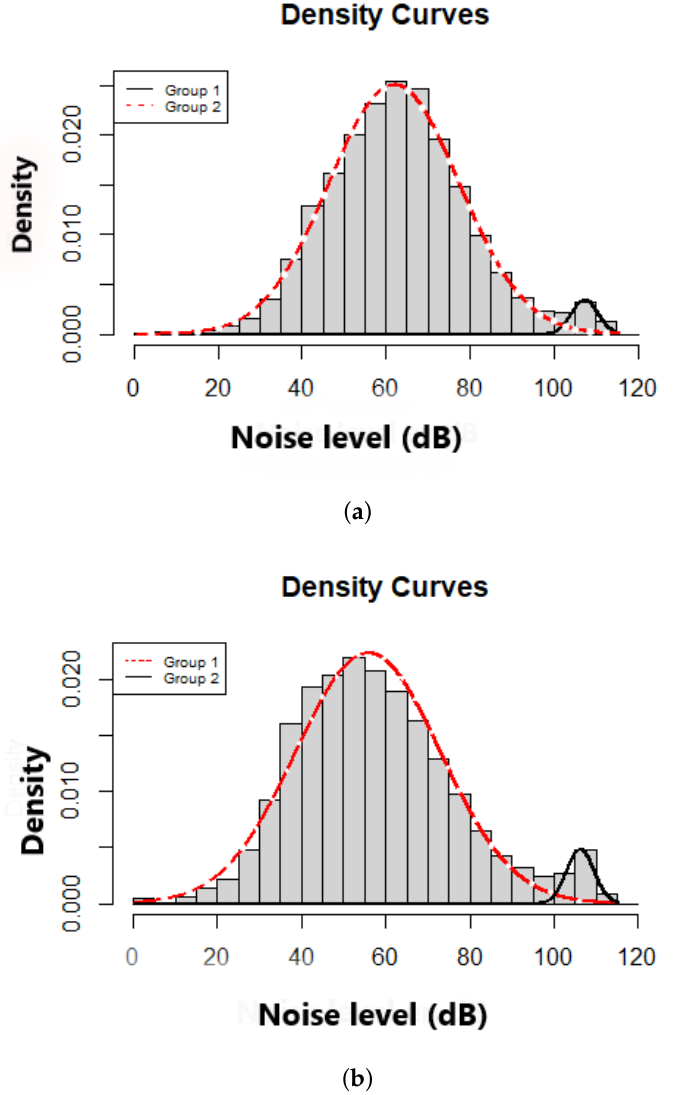
Figure 15. Distribution of noise levels ( a ) on the 260,422 tracks and ( b ) on the 59,685,328